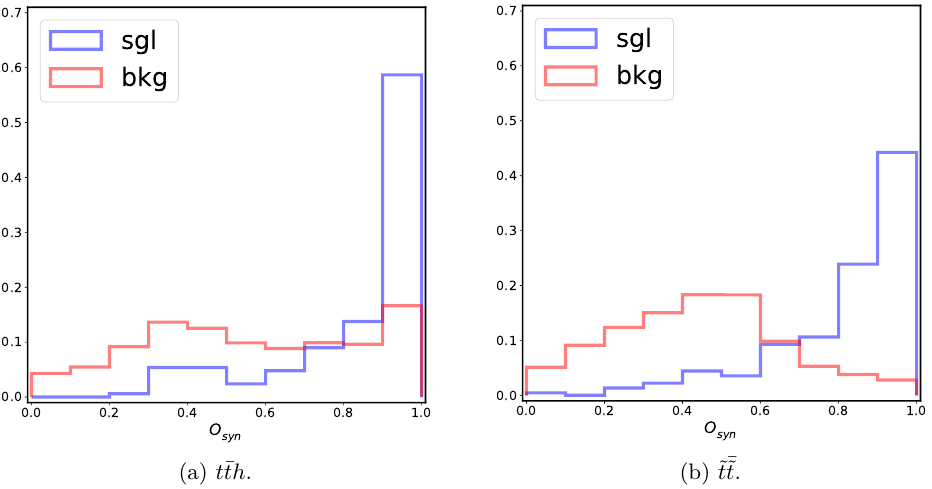
Figure 16 . Novelty score according to O syn for the signal and background events in the t ¯ tγγ analysis. The signal events considered correspond to (a) t ¯ th and (b) ˜ t ¯˜ t